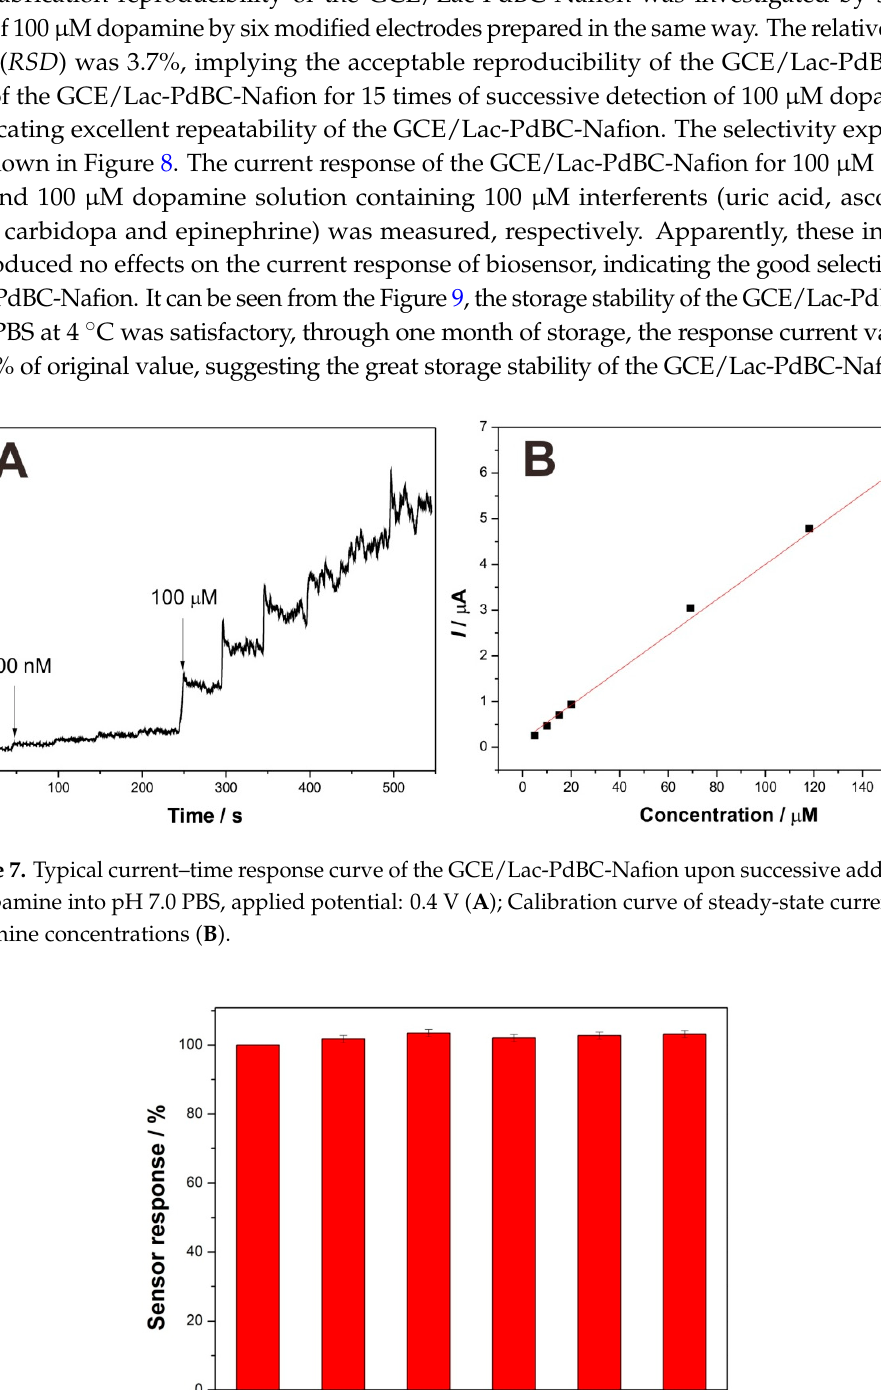
Figure 8. Selectivity of the GCE/Lac-PdBC-Nafion in pH 7.0 PBS containing different interferents. Figure 9. Storage stability of the GCE/Lac-PdBC-Nafion in pH 7.0 PBS at 4 °C. Figure 9. Storage stability of the GCE/Lac-PdBC-Nafion in pH 7.0 PBS at 4 °C.